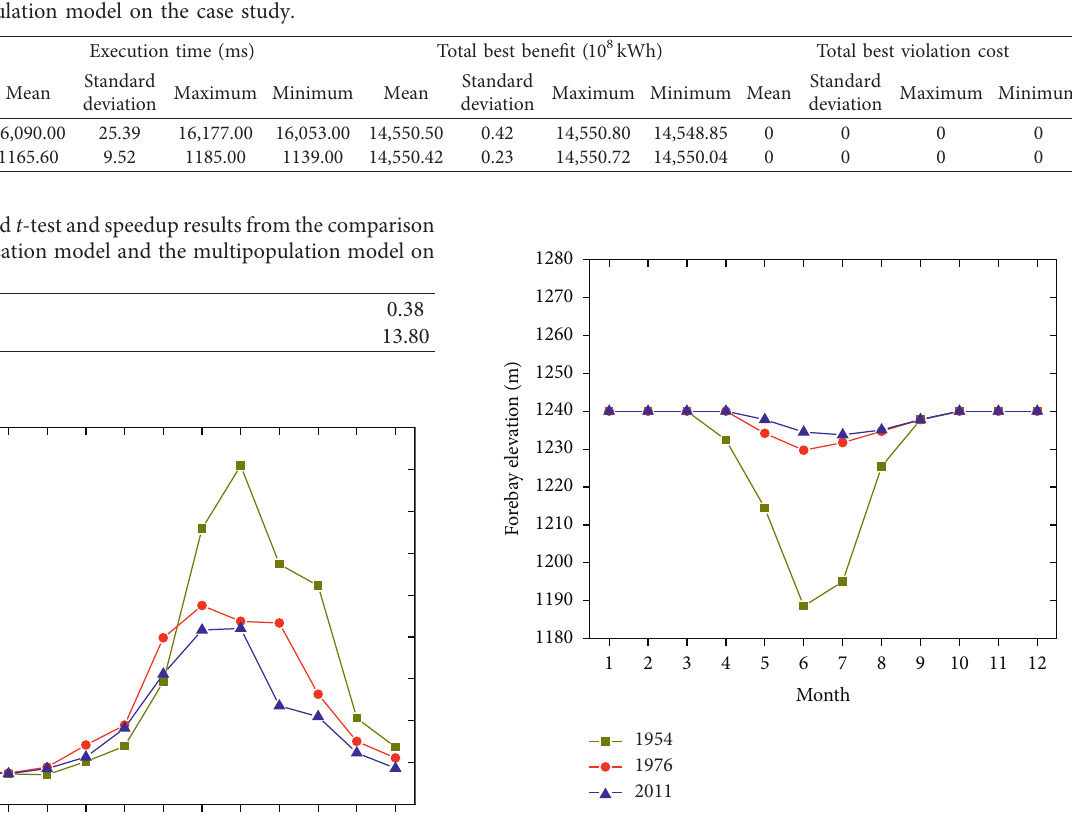
Figure 8: Forebay elevation results of the three typical years.